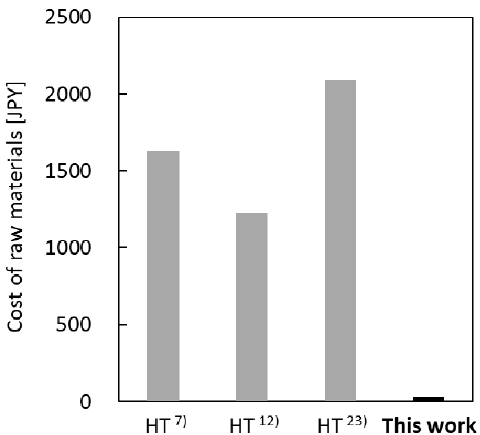
Figure 6. Comparison of raw-material costs for preparation of silicalite-1 membranes (hydrothermal synthesis (HT): gray bar; gel-free SAC: black bar).